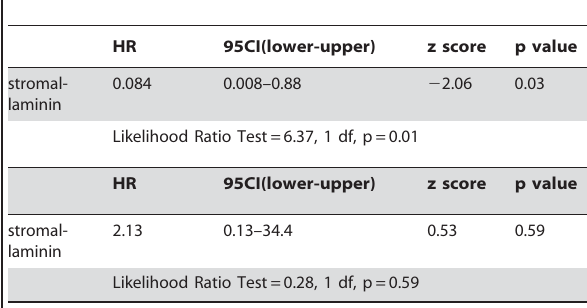
Upper model: UPPSALA estrogen receptor-negative, older women ( . 60 years of age) n=20, 3 Breast Cancer Specific Survival events censored @ 5 years. Lower model: UPPSALA estrogen receptor-negative, younger women ( , 60 years of age) n=10, 1 Breast Cancer Specific Survival event censored @ 5 years.